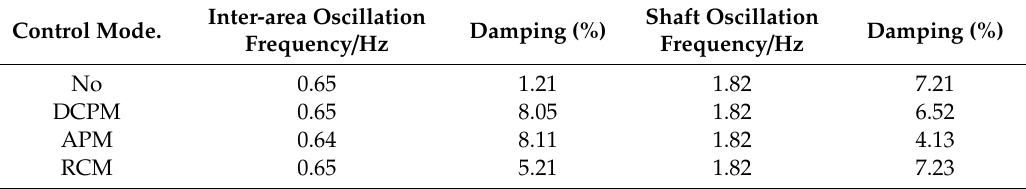
Table 2. Inter-area damping and torsional damping under various operating states and modulation methods.